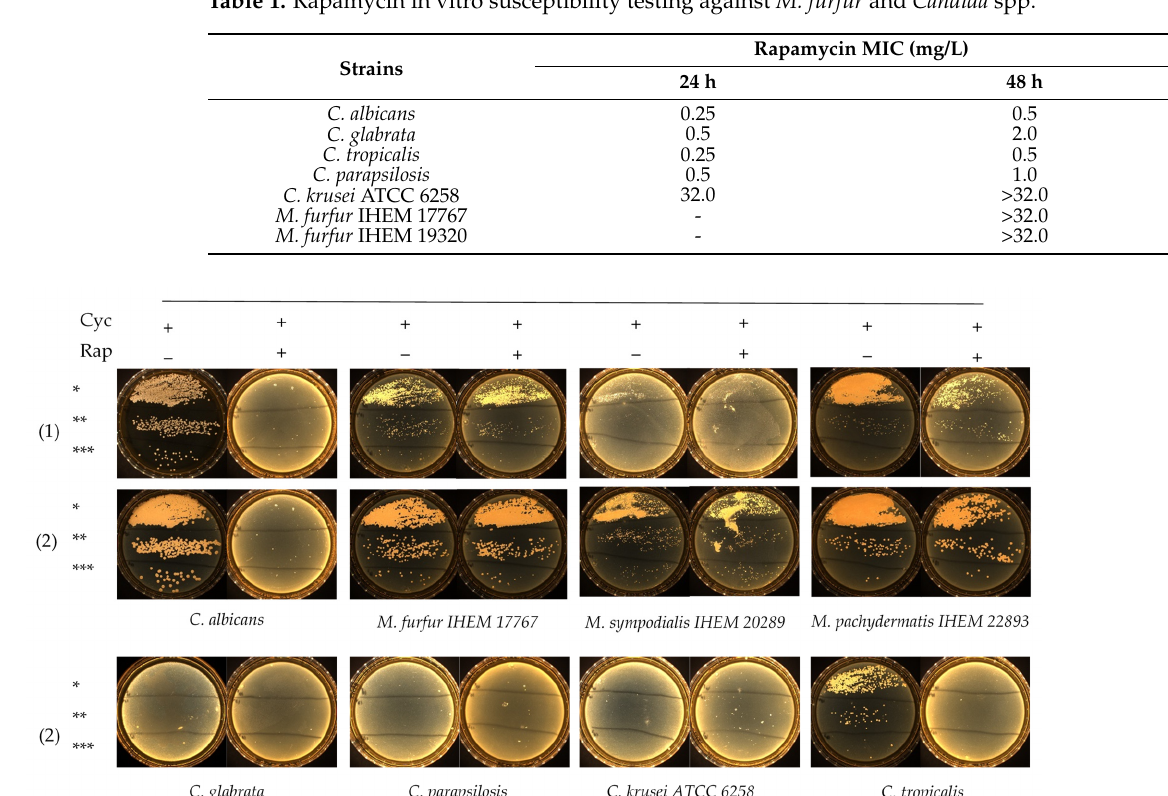
Figure 1. Growth testing via serial inocula dilution of Candida spp. and Malassezia spp. on the FastFung medium without ( − ) or with (+) 2 mg/L rapamycin (Rap) and 500 mg/L cycloheximide (Cyc). Culture at 48 h (1) and 72 h (2) of incubation. * 10 5 CFU/mL, ** 10 4 CFU/mL and *** 10 3 CFU/mL.